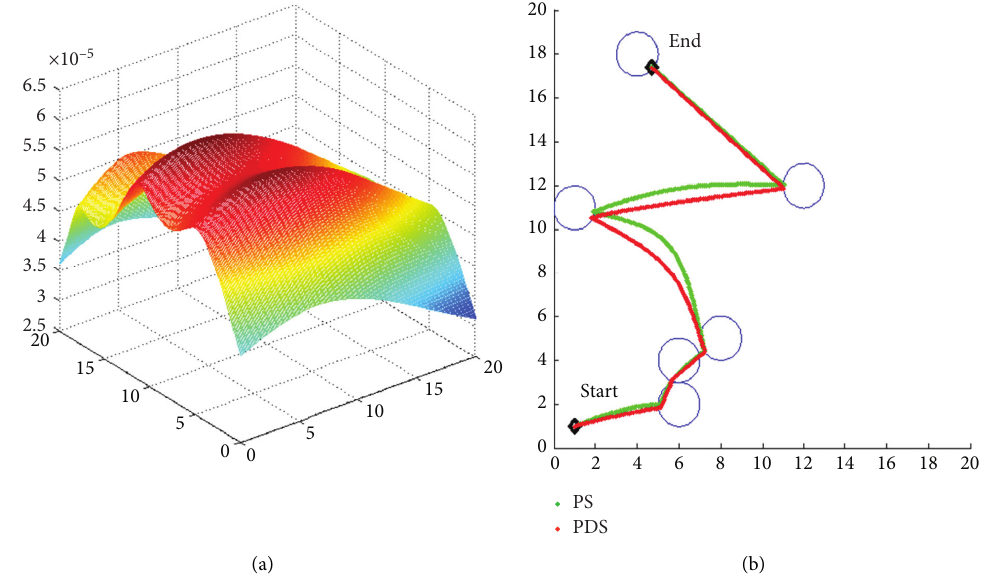
Figure 5: The simulations of robot search for multiple light sources. (a) The synthetical field intensity distribution for six light sources. (b) Trajectory comparison between PS and